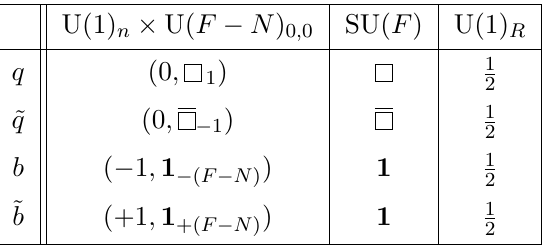
Table 3 . The magnetic U(1) n × U( F − N ) 0 , 0 gauge theory dual to table 1 with k = 0 . The theory consists of F fundamental flavors, a single U(1) charged hypermultiplet and a vector multiplet.